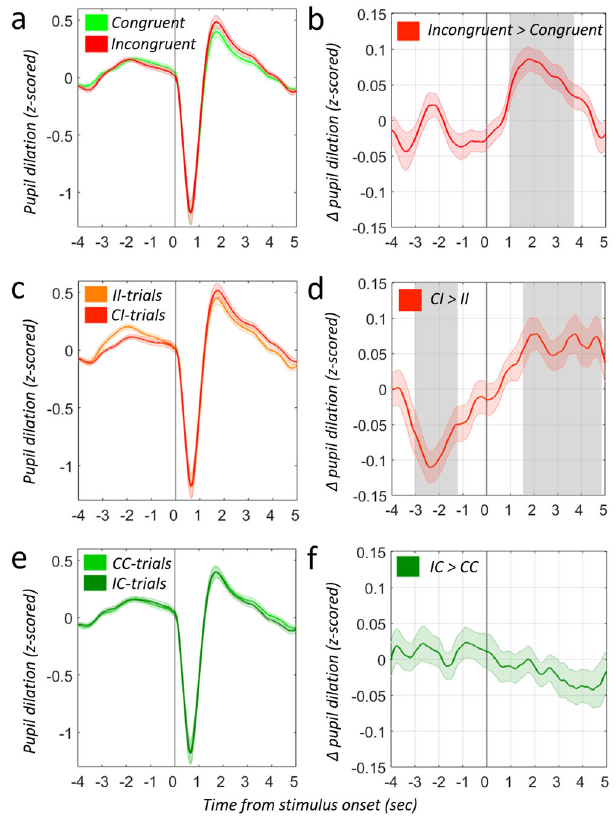
Fig. 6 Pupil dilation during response con fl ict (I > C) and upregulation (CI > II). a Mean Pupil dilation during congruent (green) and incongruent trials (red). b Pupil dilation during incongruent trials is signi fi cantly larger as compared to congruent trials. Gray shades area indicates sign. difference p < 0.05 (One-sample t test, two-sided, cluster-corrected). Vertical line indicates stimulus onset. c Mean Pupil dilation during CI trials (incongruent trials preceded by congruent trials = dark red) and II trials (incongruent trials preceded by incongruent trials = light orange). d II trials yield signi fi cantly enhanced pre-trial pupil dilation as compared to CI trials, indicating the need for noradrenergic upregulation on current CI trials. The gray shaded area indicates signi fi cant difference from zero at p < 0.05, (One-sample t test, two-sided, cluster-corrected). Vertical line indicates stimulus onset. e Mean Pupil dilation during CC trials (congruent trials preceded by congruent trials = light green) and IC trials (congruent trials preceded by incongruent trials = dark green). f Pupil dilation for CC trials does not signi fi cantly differ from IC trials before or during the current congruent trial, precluding potential light re fl ex differences (see main text). Error bands represent ±SEM at each timepoint. Source data are provided as a Source Data fi